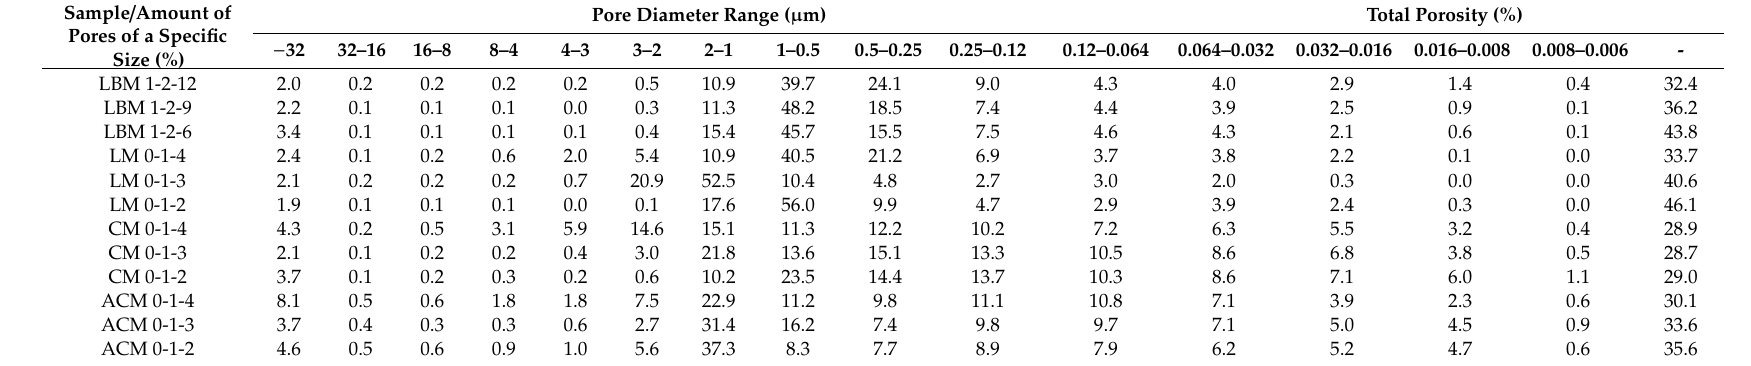
Table 4. Pore size distribution and total porosity of mortar